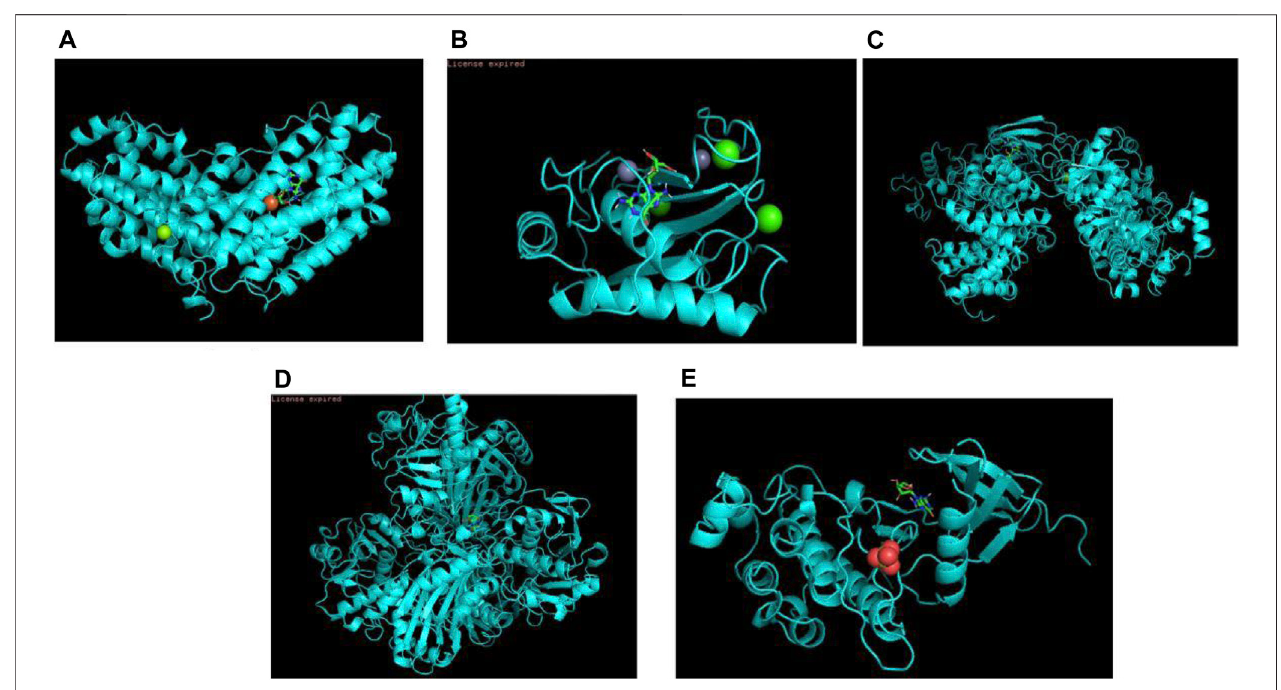
FIGURE 6 | Docking patterns of trastuzumab to core targets. (A) Docking pattern of trastuzumab to GAPDH; (B) Docking pattern of trastuzumab to MMP9; (C) Docking pattern of trastuzumab to CCNA2; (D) Docking pattern of trastuzumab to RRM2; (E) Docking pattern of trastuzumab to CHEK1.